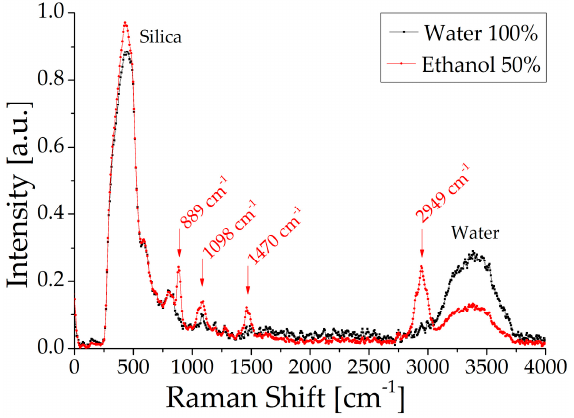
Figure 5. Raman spectra for solutions filled into hollow core fiber, showing ethanol solution ( red ) and milli-Q water ( black ).